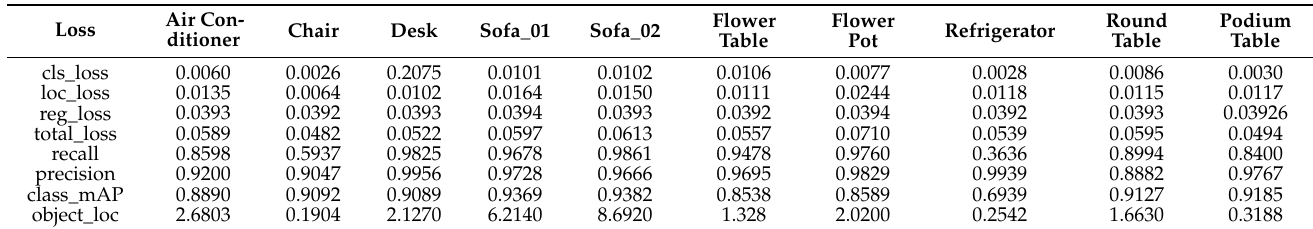
Table 3. Loss of object pose estimation in the test dataset with the improved point-GNN.